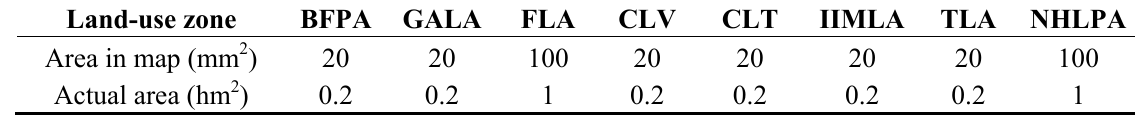
Table 4. The MPA in a land-use zoning map with 1:10,000 scale. Land-use